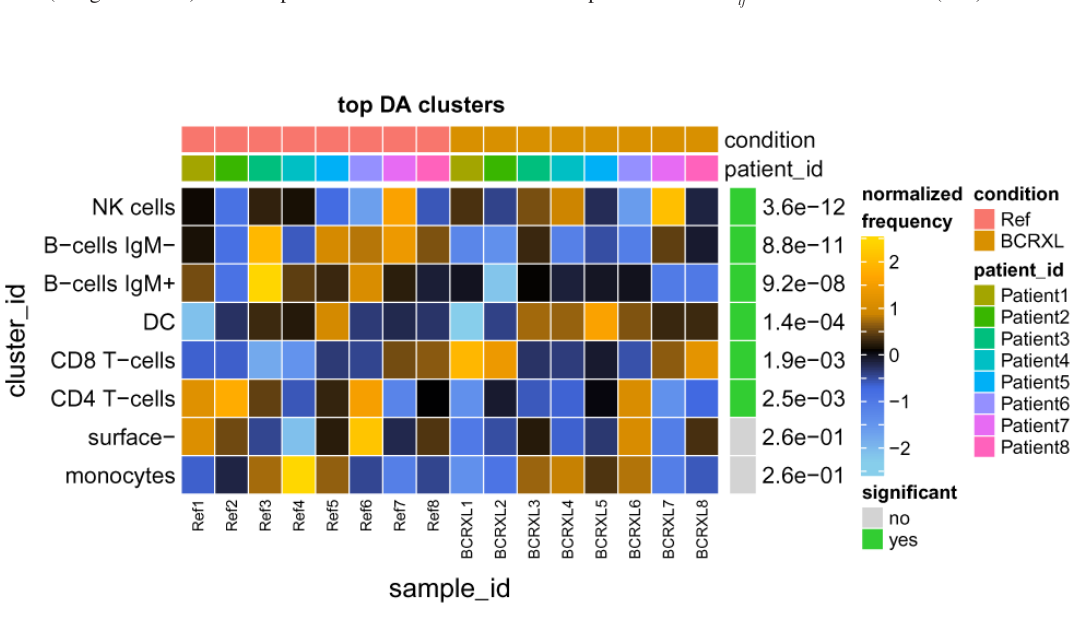
Figure 22. DA test results and normalized proportions for PBMC cell populations in BCR/FcR-XL stimulated and unstimulated conditions. The heat represents arcsine-square-root transformed cell frequencies that were subsequently normalized per cluster (rows) to mean of zero and standard deviation of one. The color of the heat varies from blue indicating relative under-representation to orange indicating relative over-representation. Bars at the top of the heatmap indicate patient IDs and the condition the samples (columns) belong to: red for the unstimulated (Ref) and brown for the stimulated with BCR/FcR-XL (BCRXL) condition. Bar and numbers at the right indicate significant differentially abundant clusters (green) and adjusted p-values. Clusters are sorted according to adjusted p-values, so that the cluster at the top shows the most significant abundance changes between the two